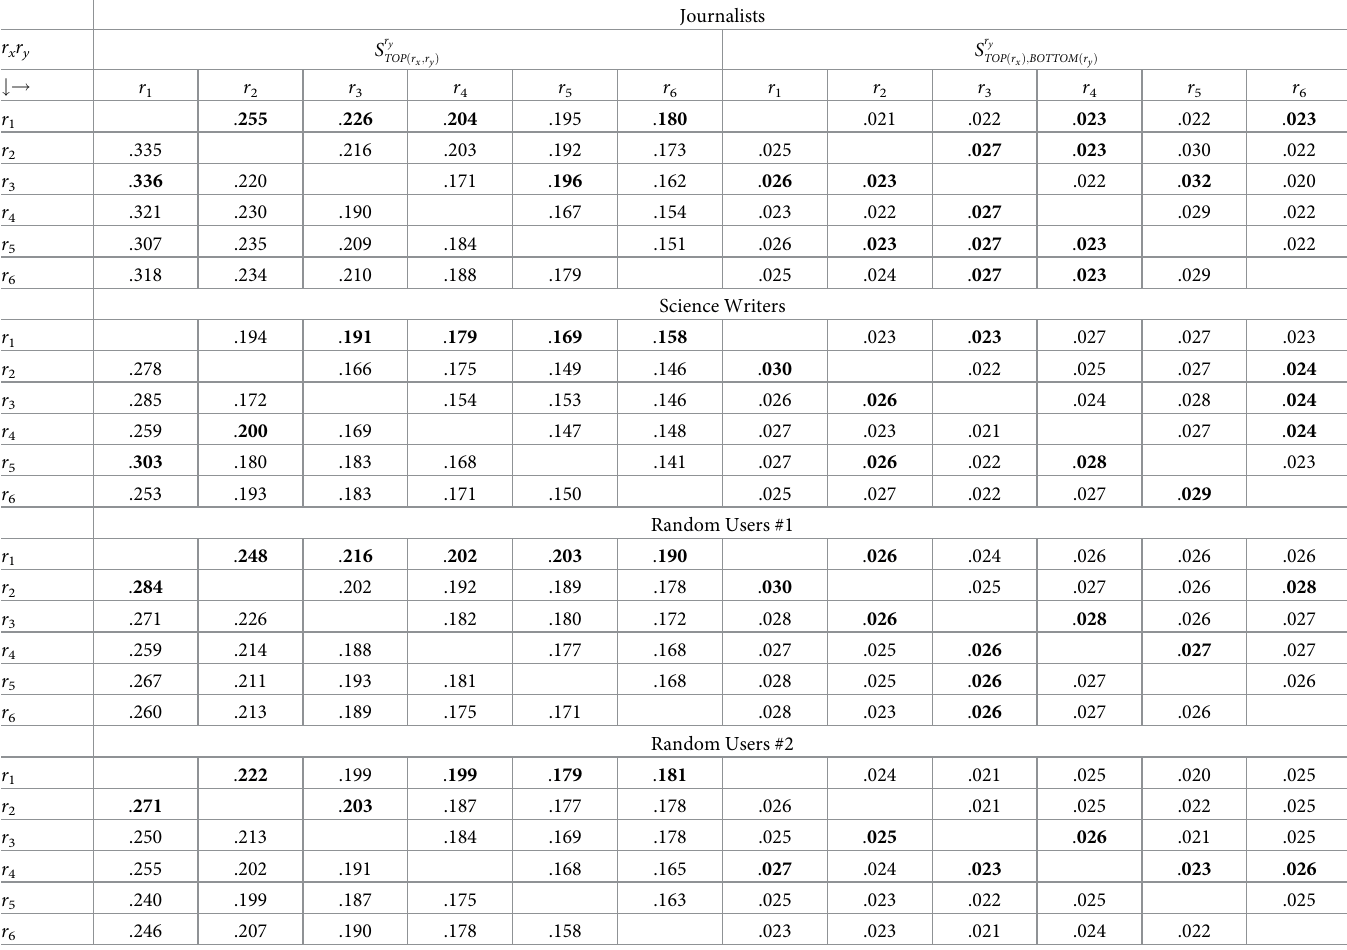
Table 6. Pulling power of primary topics. On the left, S r y responding to the r x for which the pulling power is higher in r y .